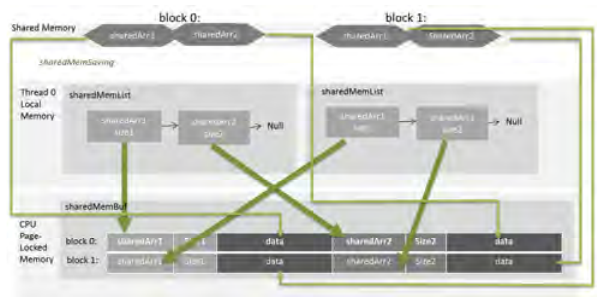
Fig. 10. Process Layout of Shared Memory Saving